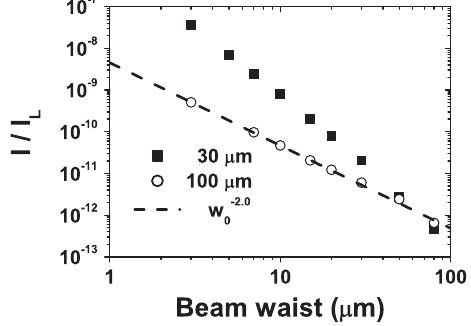
FIG. 7. Change of the radiation efficiency (radiation energy I divided by the energy of the driving laser I L ) with respect to beam waist of 0.5 nC electron bunches of radius 30 (cid:1) m (solid square) and 100 (cid:1) m (open square). The laser intensity was kept constant ( a 0 ¼ 10 ). The electron bunch of 30 (cid:1) m radius is the same as in Figs. 5 and 6; other specifications of electron bunches are the same as in Figs. 5 and